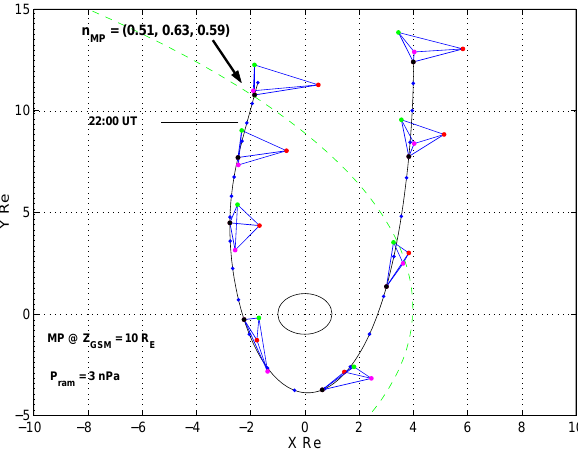
Fig. 9. Cluster trajectory in the GSE X − Y plane, at a constant Z GSM of 10 R E on 9 December 2000 (black, red, green and magneta represent the Cluster 1, 2, 3 and 4 spacecraft respectively, and the spacecraft separations are magnified by a factor of 20). The posi- tion of a model magnetopause for a 3nPa dynamic pressure, and the location of Cluster 1 at 22:00UT is also shown. Also indicated is the GSE vector direction of the model magnetopause normal (n MP ) at the position where the Cluster trajectory crosses the model mag-